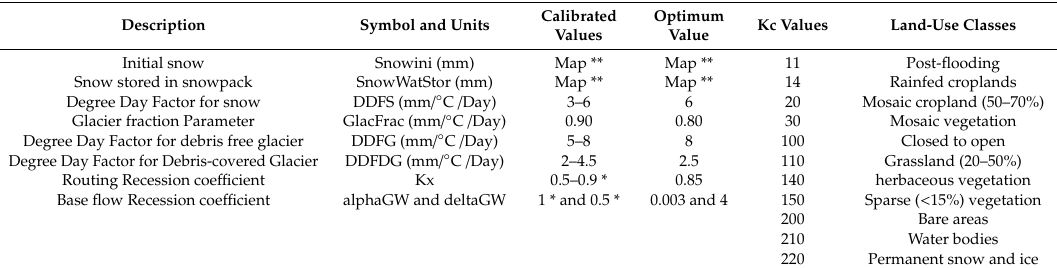
Table 4. Parameters used for calibration of SPHY in